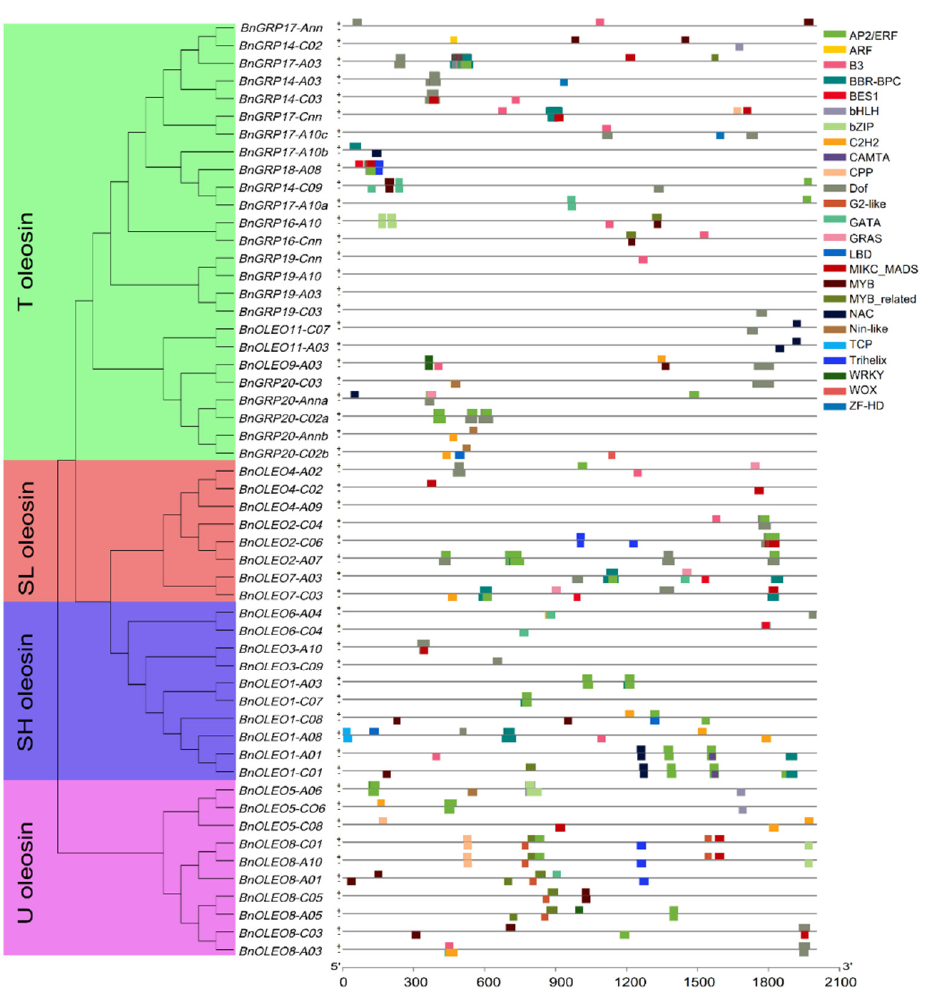
Figure 2. Transcription factor (TF) binding site analysis in the oleosin gene promoter. Boxes with different colors represent different transcription factor families. “+” and “ − ” represent positive and negative strands, respectively.